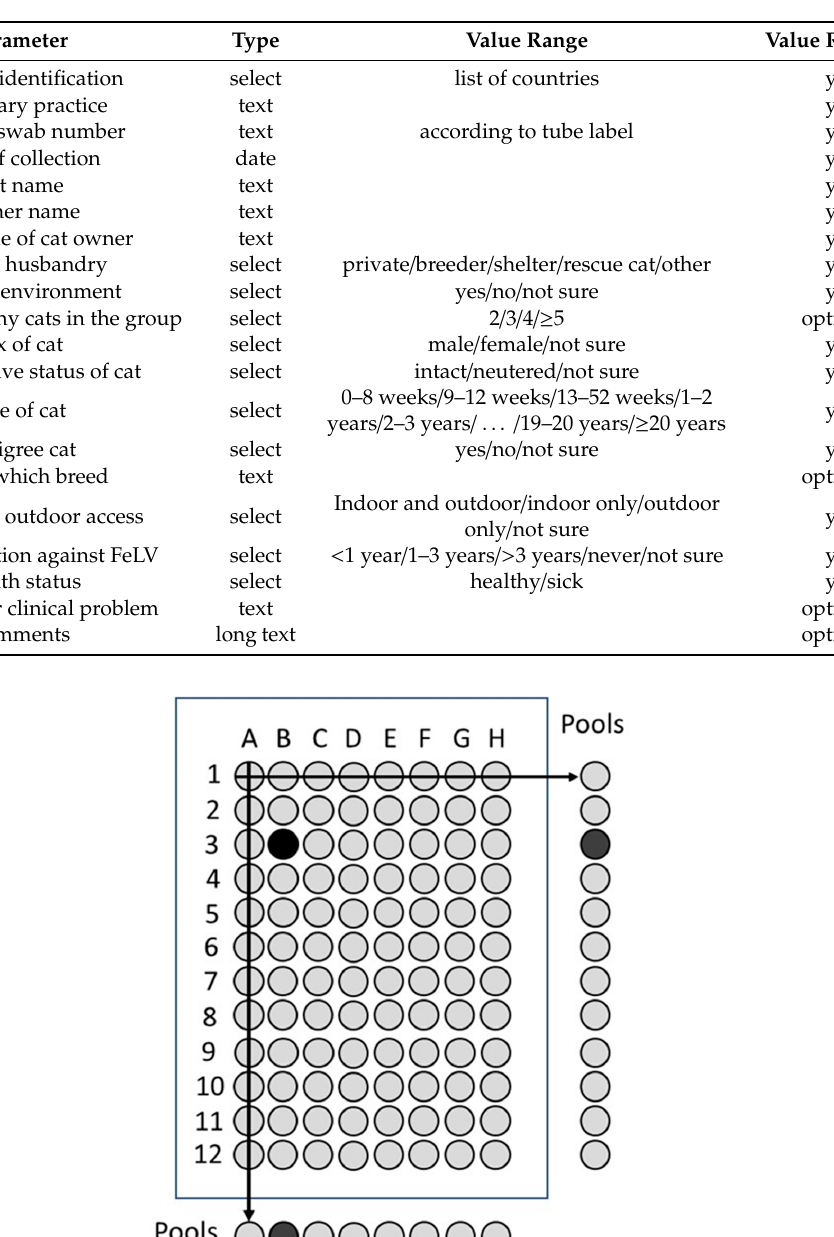
Table A1. Online Questionnaire.